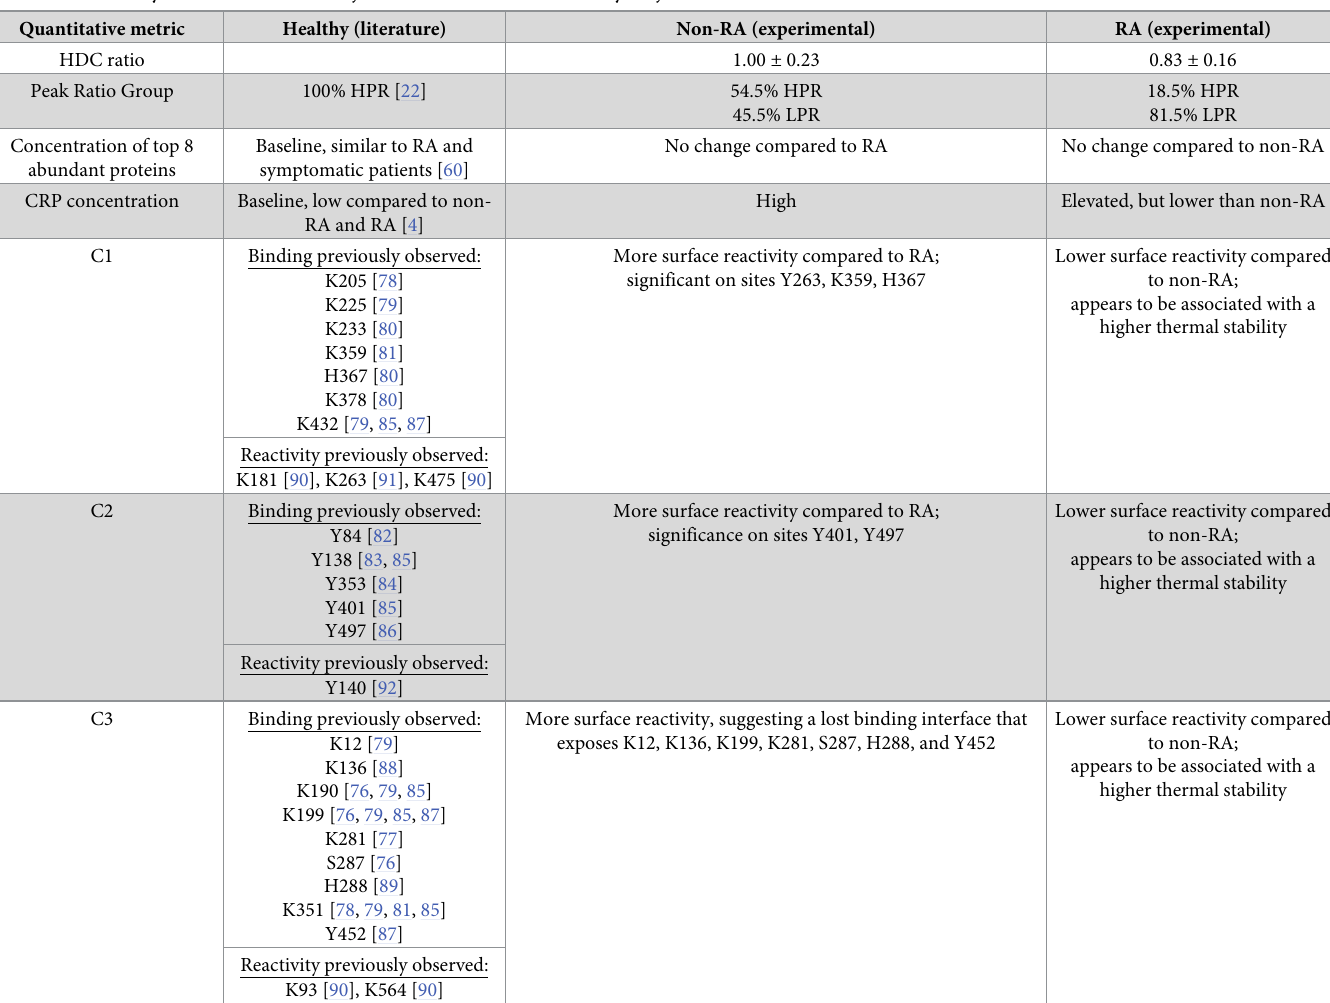
Table 2. A summary of non-RA and RA subjects versus literature for healthy subjects. Quantitative